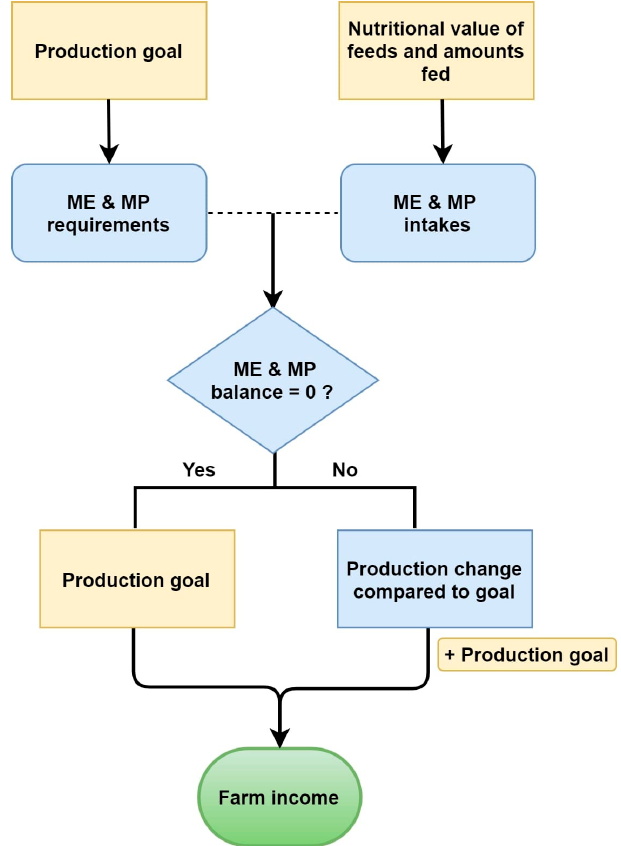
Figure 1. Flow diagram with the basic steps of the iSAGEDSS algorithm; ME and MP refer to metabolizable energy and metabolizable protein, respectively.